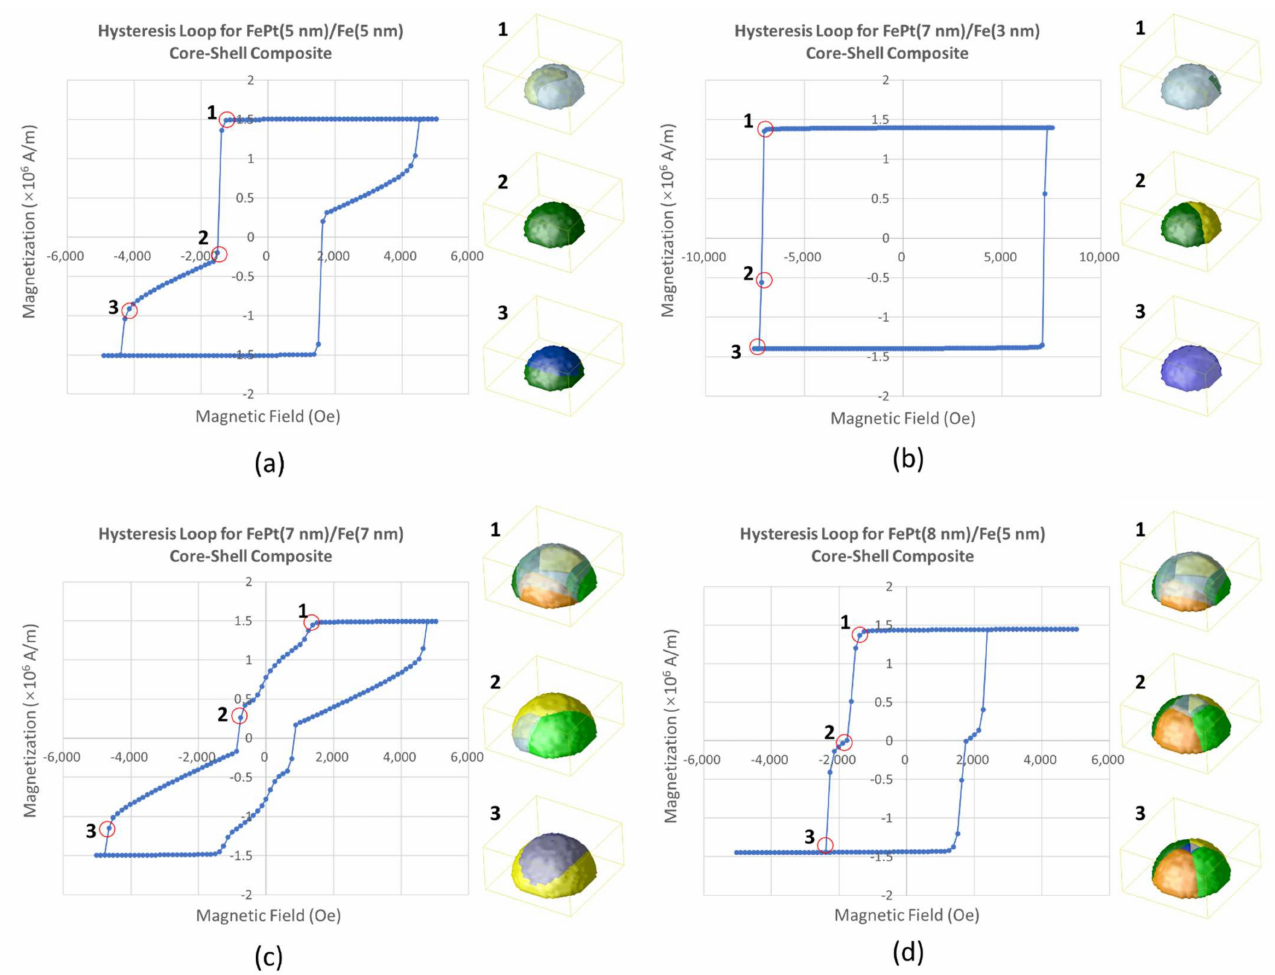
Figure 2. ( a – d ) Magnetic hysteresis loops of FePt/Fe core-shelled structure measured in the out-of- plane directions for the switching type of A–D, respectively. The simulated corresponding magnetic domain structure evolution during the switching process at the position of three circles 1, 2, 3 are shown at the right of the loop. Each color represents a type of ferromagnetic domain: yellow/orange represents +x/ − x domains, green/dark green represents +y/ − y domains, and blue/light blue represents +z/ − z